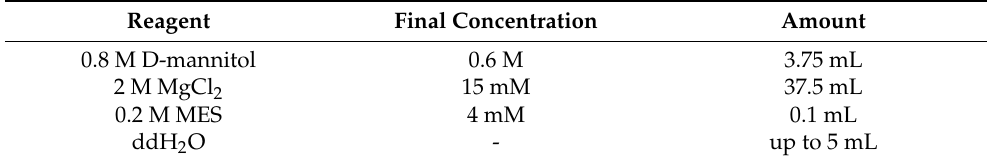
Table 4. Composition of MMG buffer (5 mL).